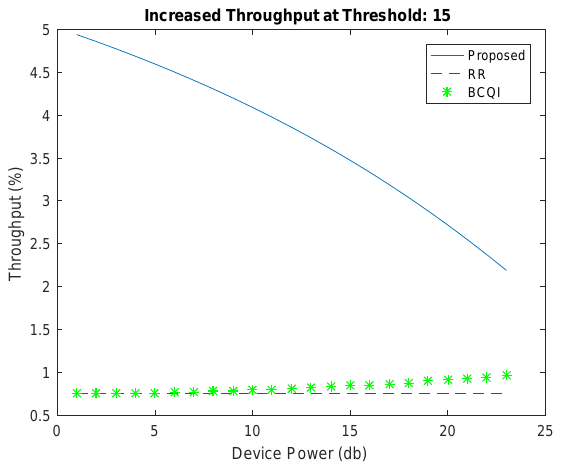
Figure 9. Throughput at threshold